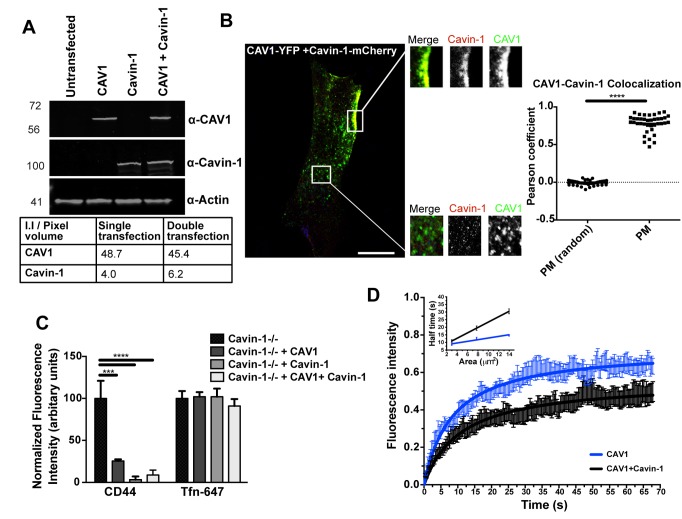
Caveolae generation down-regulates CLIC endocytosis.(A) Cell lysates from untransfected Cavin-1−/− MEFs or Cavin-1−/− MEFs transiently transfected with CAV1-YFP or Cavin-1-mCherry or co-transfected with CAV1-YFP and Cavin-1-mCherry were immunoblotted for CAV1 and Cavin-1. Actin was used as loading control. For quantification, the integrated intensity of protein bands was calculated. (B) Representative image of cell from (A) showing colocalization between CAV1 and Cavin-1 at different subcellular locations. Insets depict CAV1, Cavin-1 and merged labeling at the plasma membrane and cytosolic regions, marked by the square. 40 cells from (A) were subjected to Pearson correlation analysis, and a representative graph is shown. (C) Cells from (A), growing on coverslips, were subjected to internalization assay with anti-CD44 mAb and Tfn-647 for 2 min at 37°C. Cells were acid washed prior to fixation and internalized anti-CD44 mAb was labeled with AF-555 secondary antibody. 40–50 cells were quantified for normalized fluorescent intensity of endocytic markers. (D) FRAP analysis for CAV1 diffusion at the plasma membrane of Cavin-1−/− MEFs expressing CAV1-YFP alone or co-expressing CAV1-YFP and Cavin-1-mCherry. Fluorescence recovery curve and lateral diffusion analysis (inset) from 15 cells (mean ± SD) are shown. In (B) data represent mean ± SEM of data pooled from three independent experiments and in (C) data represent mean ± SEM of three independent experiments. ***p<0.0005,****p<0.0001 (two-tailed t-test). Scale bar: 10 µm.